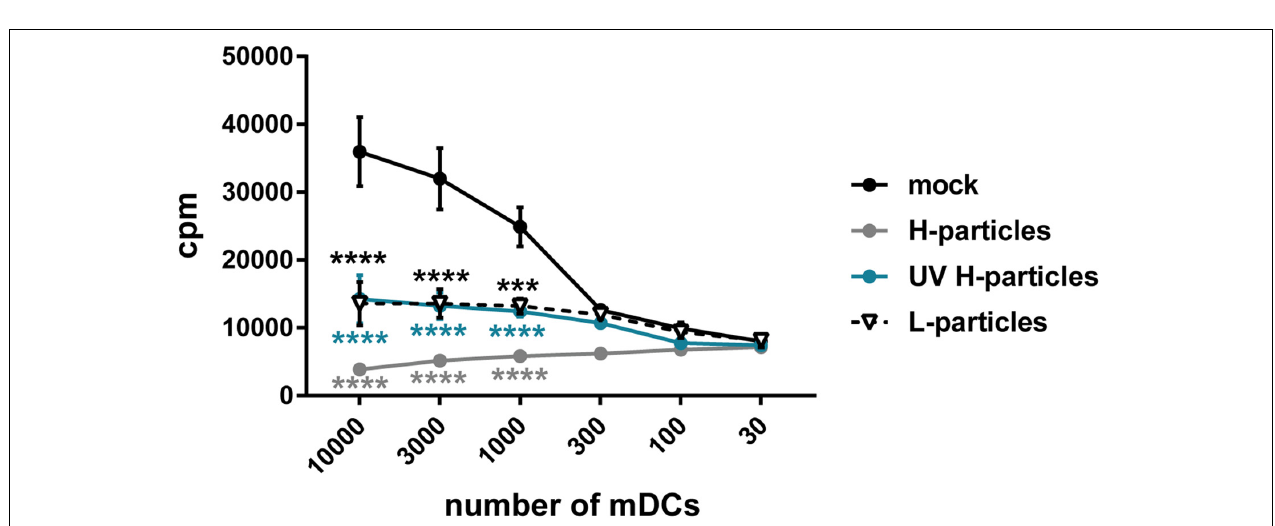
FIGURE 8 | L-particles possess an immunomodulatory effect on mDCs. Mature DCs (mDCs) were infected with purified H-particles (MOI of 2), treated with UV–irradiated H-particles (viral material corresponding to MOI of 20, 8 × 0.12 J/cm 2 ) or L-particles (viral material corresponding to high MOI, 3 × 0.12 J/cm 2 ) or left untreated (mock). At 8 hpi, cells were cocultured with allogeneic T cells in a mixed lymphocyte reaction (MLR) for additional 72 h. Cells were pulsed with 1 µ Ci/well [3H]-thymidine (PerkinElmer) for 16 h before harvesting. The experiment was performed three times with mDCs from different healthy donors. Error bars indicate SEM. Statistical analyses was performed relative to mock values and is depicted on the right side. Only the significant changes to mock were analyzed using a one-way ANOVA and Bonferroni multiple comparison post hoc tests and only significant changes are indicated by asterisks (*indicates p ≤ 0.05, ** p ≤ 0.01, *** p ≤ 0.001, and **** p ≤